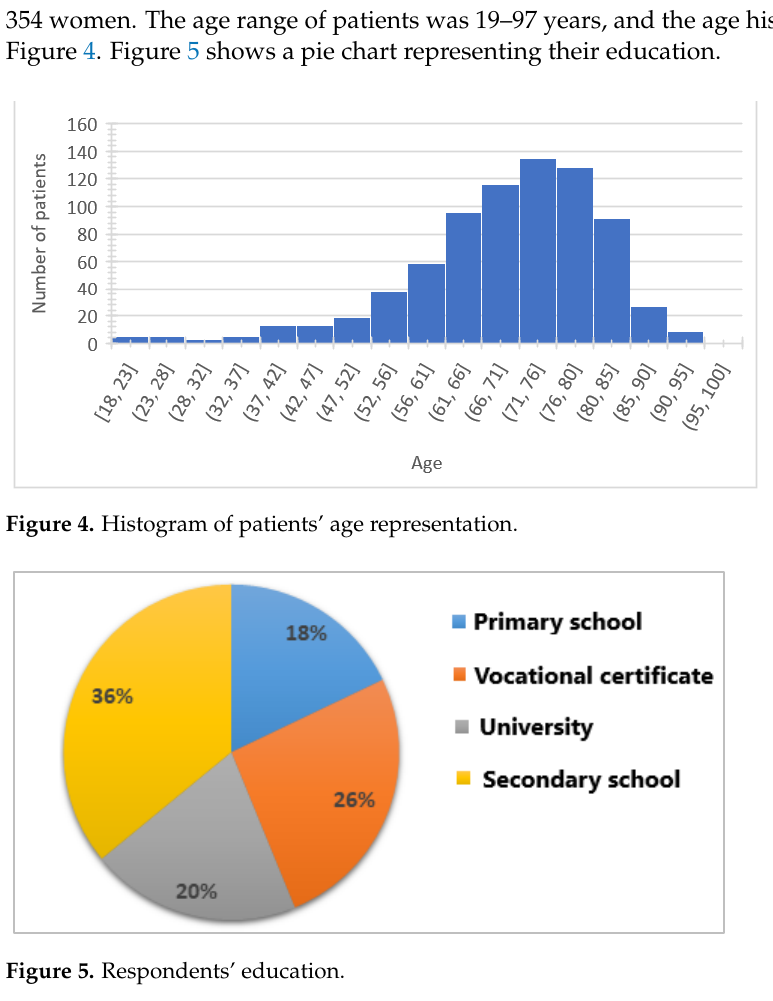
Figure 4. Figure 5 shows a pie chart representing their education.